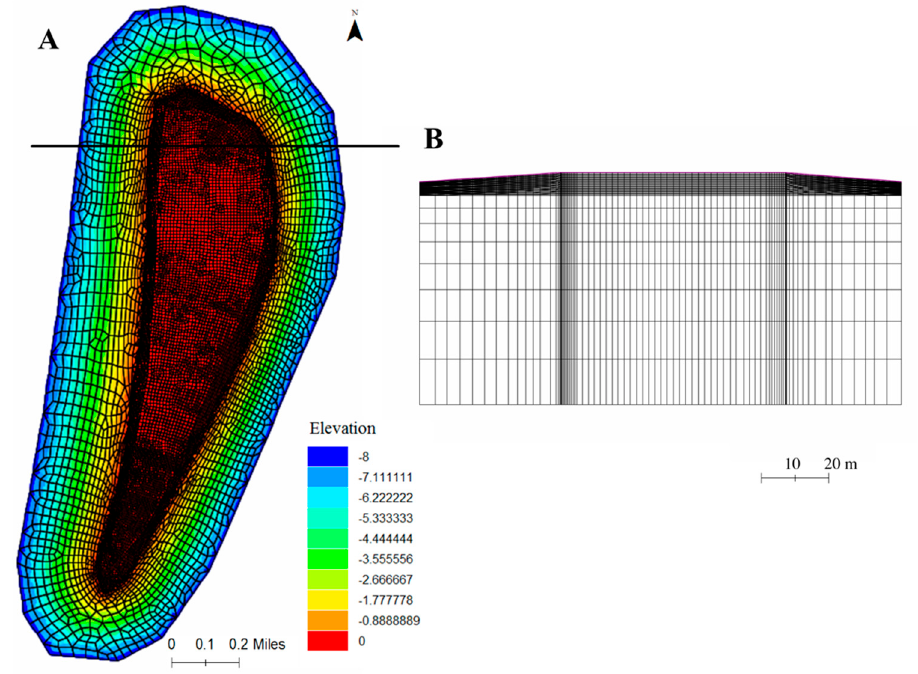
Figure 3. ( A ) Top view of the finite element mesh used for the SUTRA model of Gan Island, with colors indicating elevation (m) above sea level. The red elements indicate the surface area of the island, with the remaining elements depicting the shallow coastal areas of the island. ( B ) Cross section view of the mesh for the black line transect shown in Figure 3A, showing the vertical discretization of the elements to represent the aquifer.